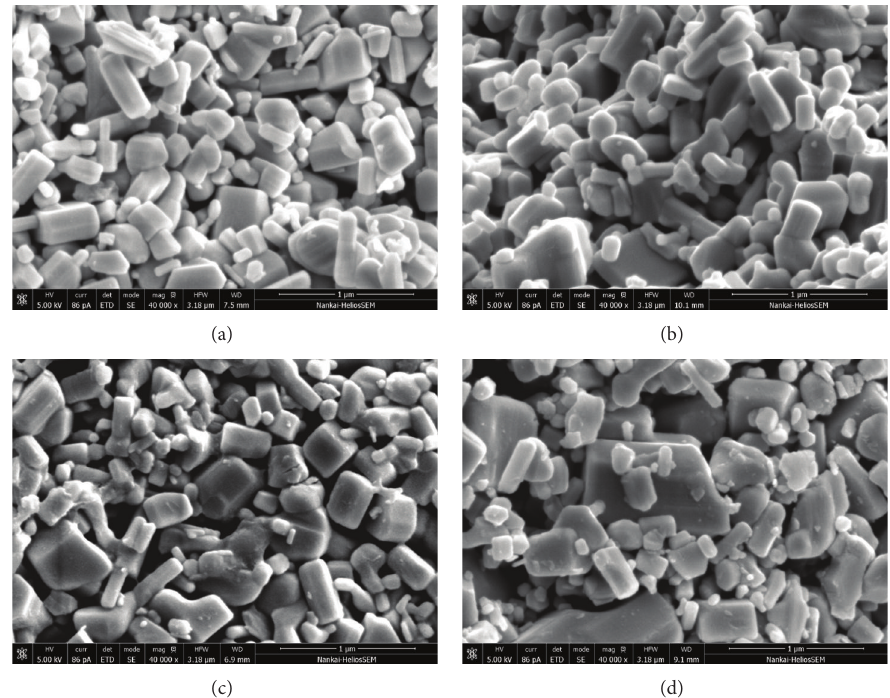
Figure 2: Fracture morphology of AZO green compacts prepared in different particle sizes ((a) 45 nm, (b) 120nm, (c) 230 nm, and (d) 510 nm).